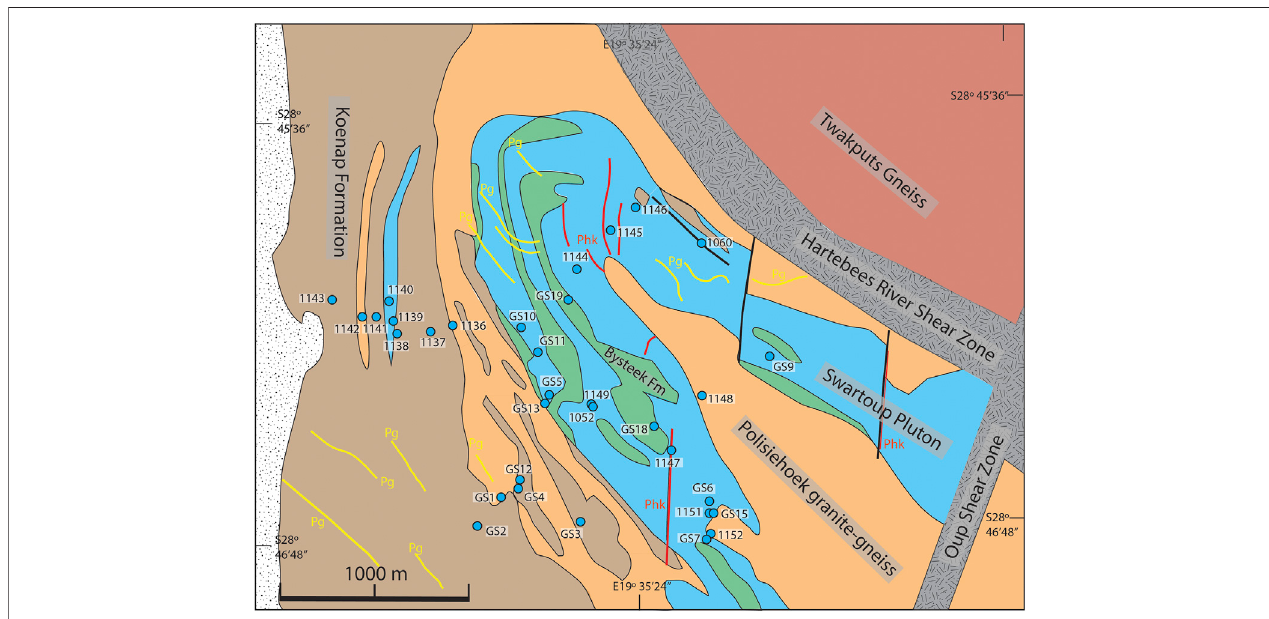
FIGURE 2 | Simpli fi ed geological map of the study area ( Figure 1B ) showing the distribution of lithological entities, main structures, and sample locations. Pg, pegmatites (in yellow); Phk, Polisiehoek Granite dykes (in red). Pegmatites are post-orogenic and undeformed. Polisiehoek Granite dykes commonly show sheared boundaries or, in some places, penetrative